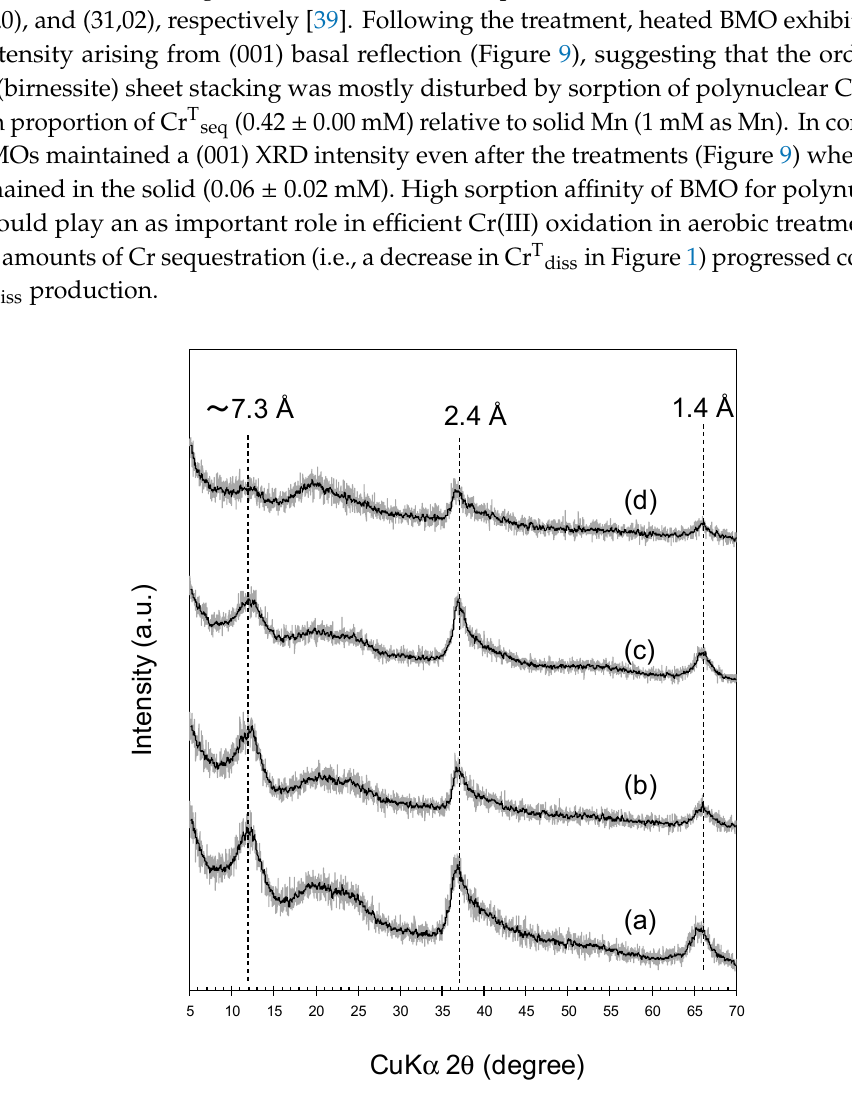
Figure 9. X-ray Di ff raction (XRD) of newly formed and heated BMOs before and after treatments in Figure 9. X-ray Diffraction (XRD) of newly formed and heated BMOs before and after treatments in 0.5 mM Cr(NO 3 ) 3 / 100 mM MES (pH 6.0) for 24 h under aerobic condition. Newly formed BMOs ( a 0.5 mM Cr(NO 3 ) 3 /100 mM MES (pH 6.0) for 24 h under aerobic condition. Newly formed BMOs ( a ) before and ( b ) after the treatments, and heated BMOs ( c ) before and ( d ) after the treatments.